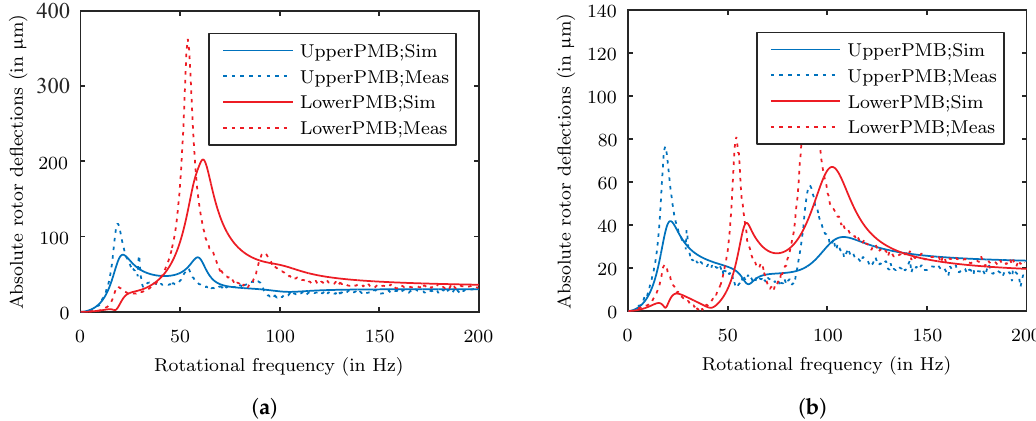
Figure 12. Comparison of the measured data with the simulated deflections with “Unbalance1” ( a ) and “Unbalance2” ( b ) specified in Table